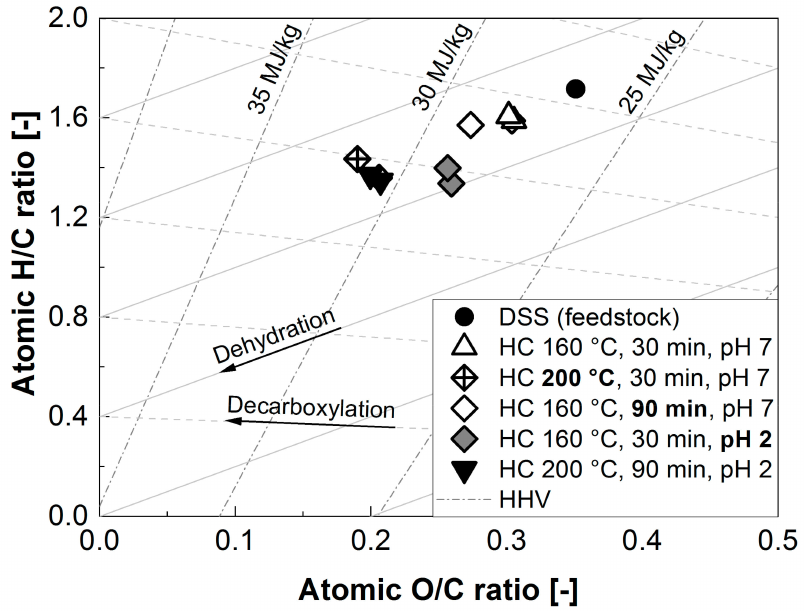
Figure 2. van-Krevelen-diagram of selected hydrochars (HC) and digested sewage sludge (DSS) at di ff erent process